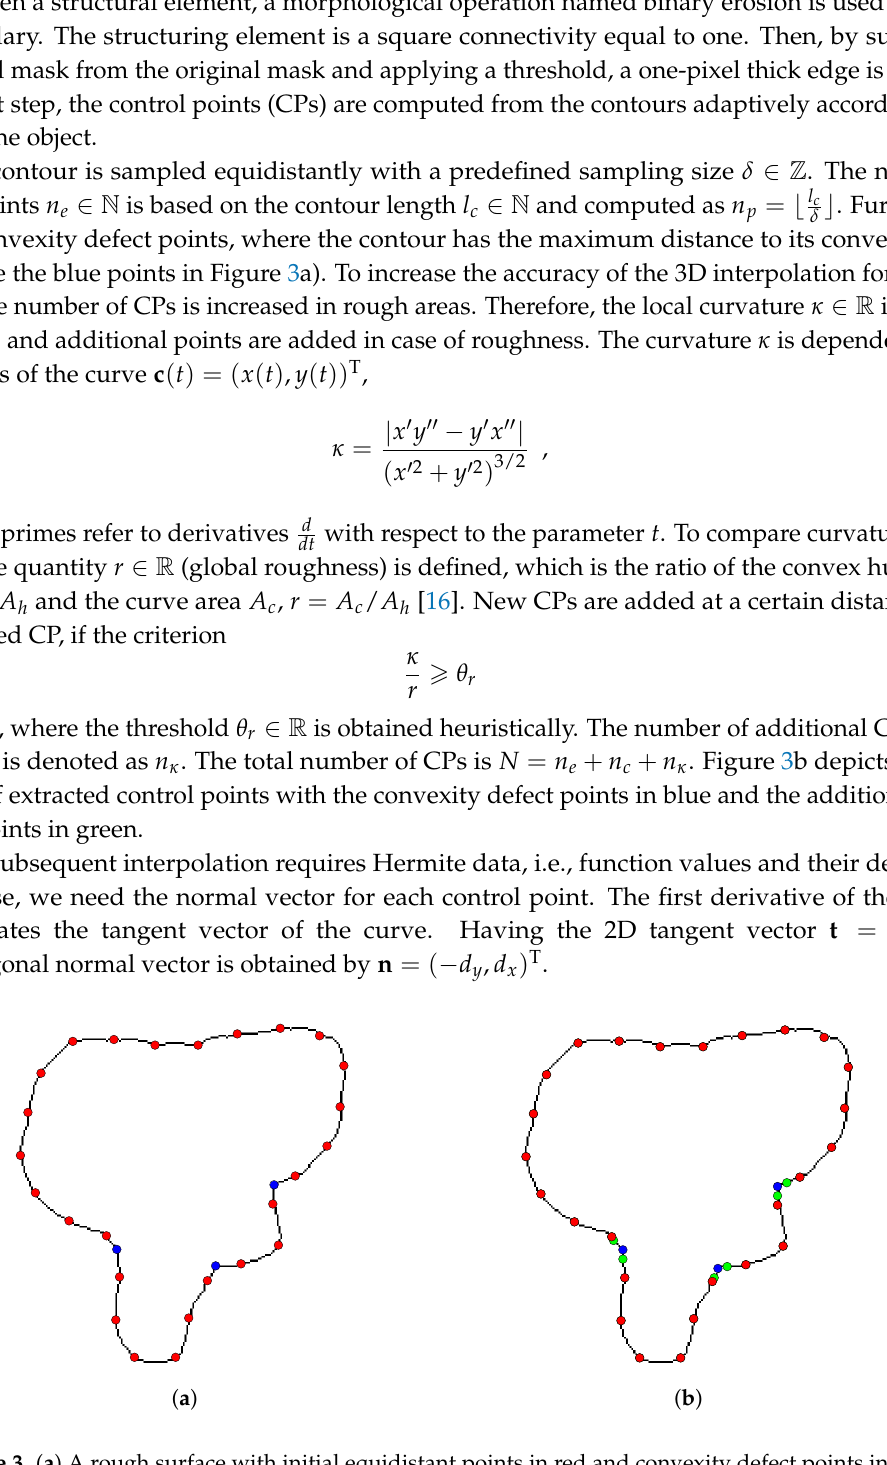
Figure 3. ( a ) A rough surface with initial equidistant points in red and convexity defect points in blue; ( b ) A rough surface with increased number of points in green ([2] Reproduced with